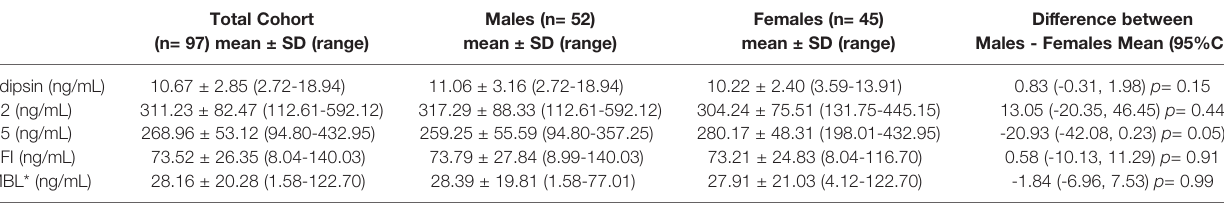
TABLE 2 | Synovial fl uid complement concentrations: total cohort and disaggregated by sex. Total Cohort (n= 97) mean ± SD (range)